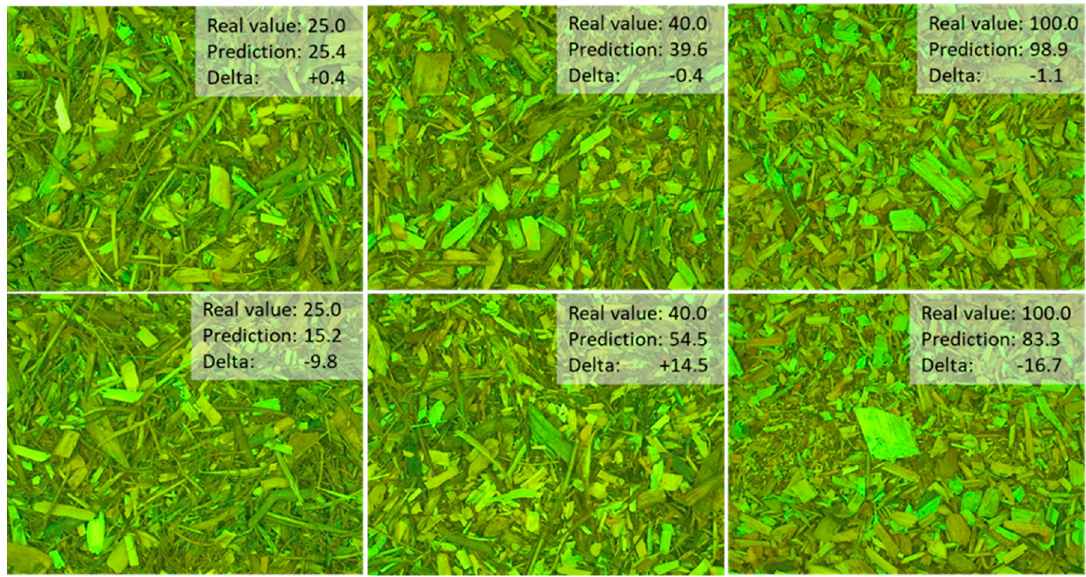
Figure 8. Exemplary high and low accuracy predictions for different fuel classes (Settings: GB regressor, R 2 (validation set) = 0.885, RMSE = 6.91).